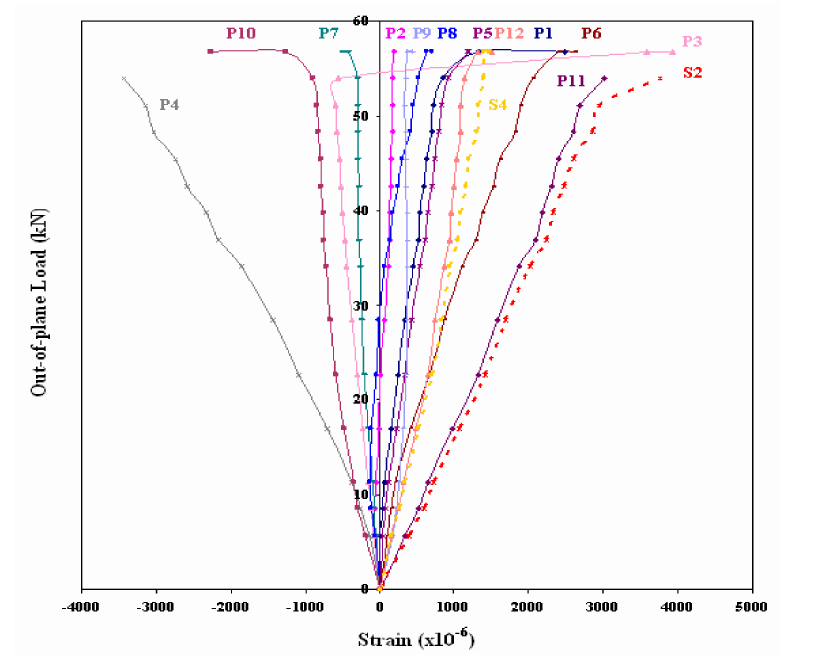
Figure 14. Load–strain behavior of LSTP4.